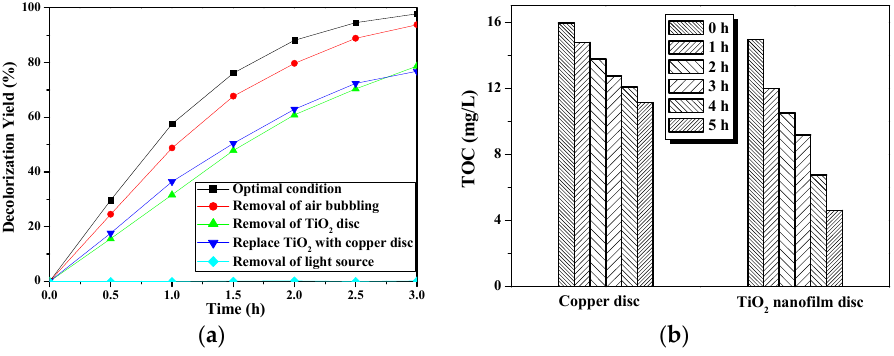
Figure 8. Photocatalytic activity tests of the photocatalytic rotating disc reactor (PRD-reactor). Reaction conditions: ( a ) 15 mg/L MO and ( b ) 20 mg/L phenol. Volume of degradation solution: 5 L; light source: 3 × 10 W UV lamp; photocatalyst: TiO 2 nanowire deposited on 0.8 mm substrate with active area of 1248 cm 2 ; disc rotating speed: 33 rpm. The optimal conditions meant that the experiment was conducted under all above-mentioned conditions, with air bubbling employed.